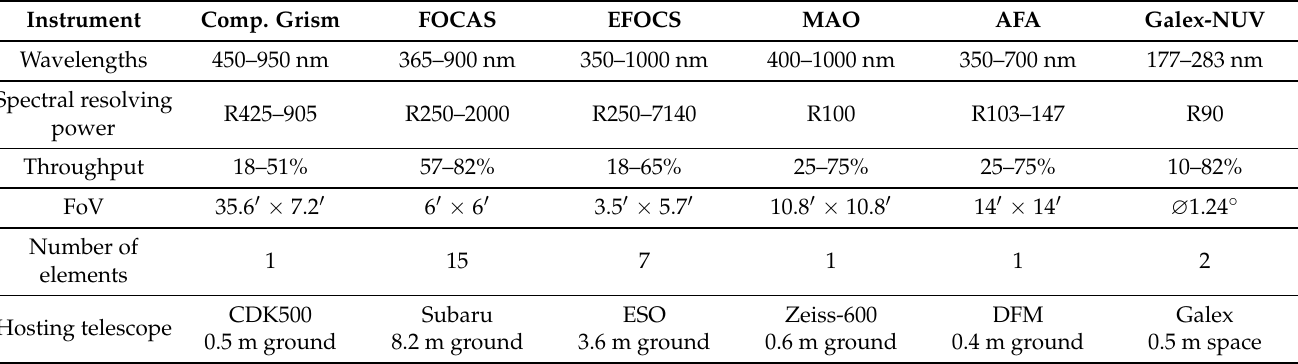
Table 7. Spectrograph characteristics